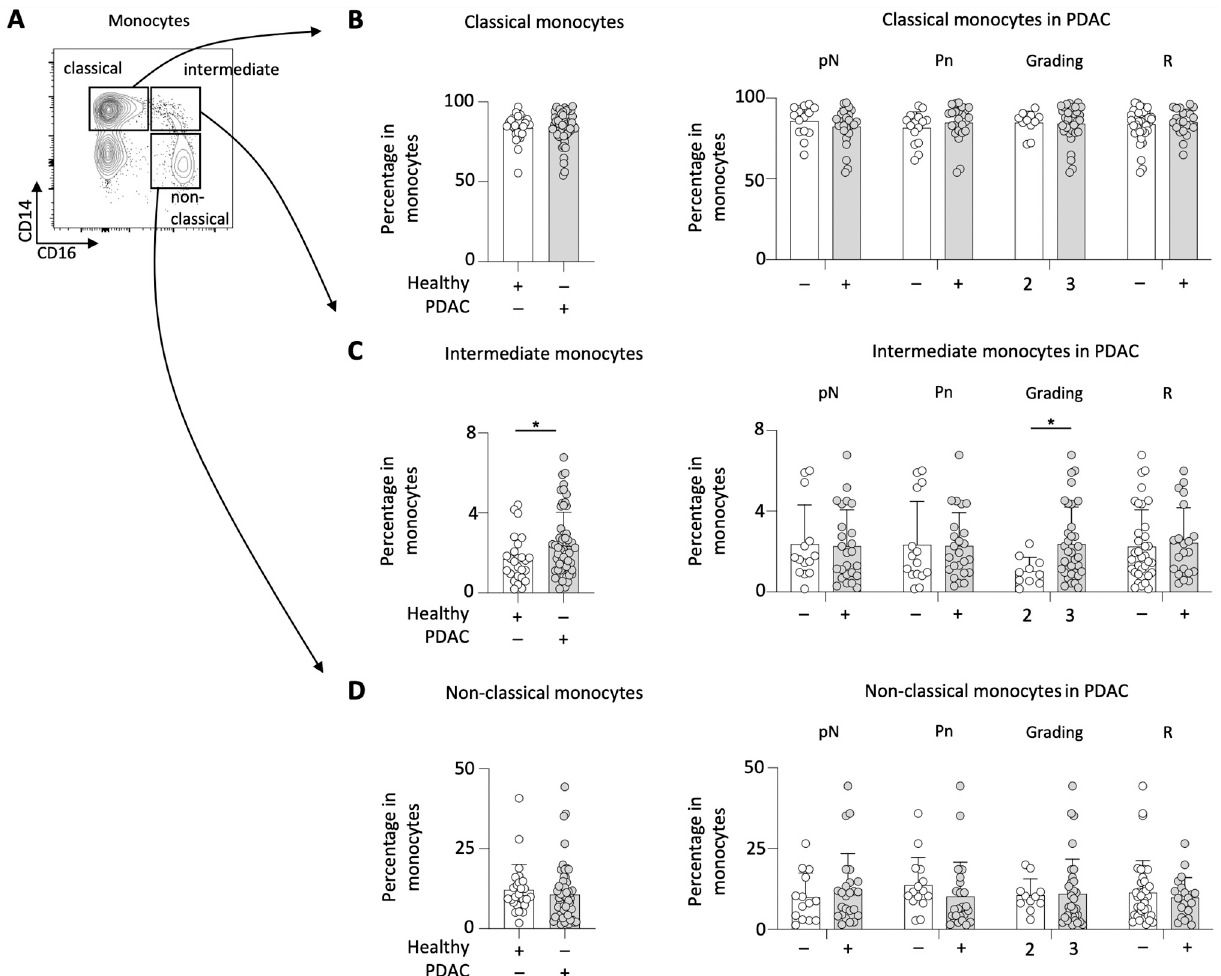
Figure 4. PDAC patients showed increased frequencies of intermediate monocytes. Gating strategy applied to characterize circulating monocyte subsets in PDAC patients ( A ), percentage of classical monocytes ( B ), intermediate monocytes ( C ), and non-classical monocytes ( D ) in PDAC patients compared to healthy controls and their correlation with the disease severity (lymph node status (pN), perineural invasion (Pn), the tumor grading (G) and the resection status (R)); * p < 0.05.